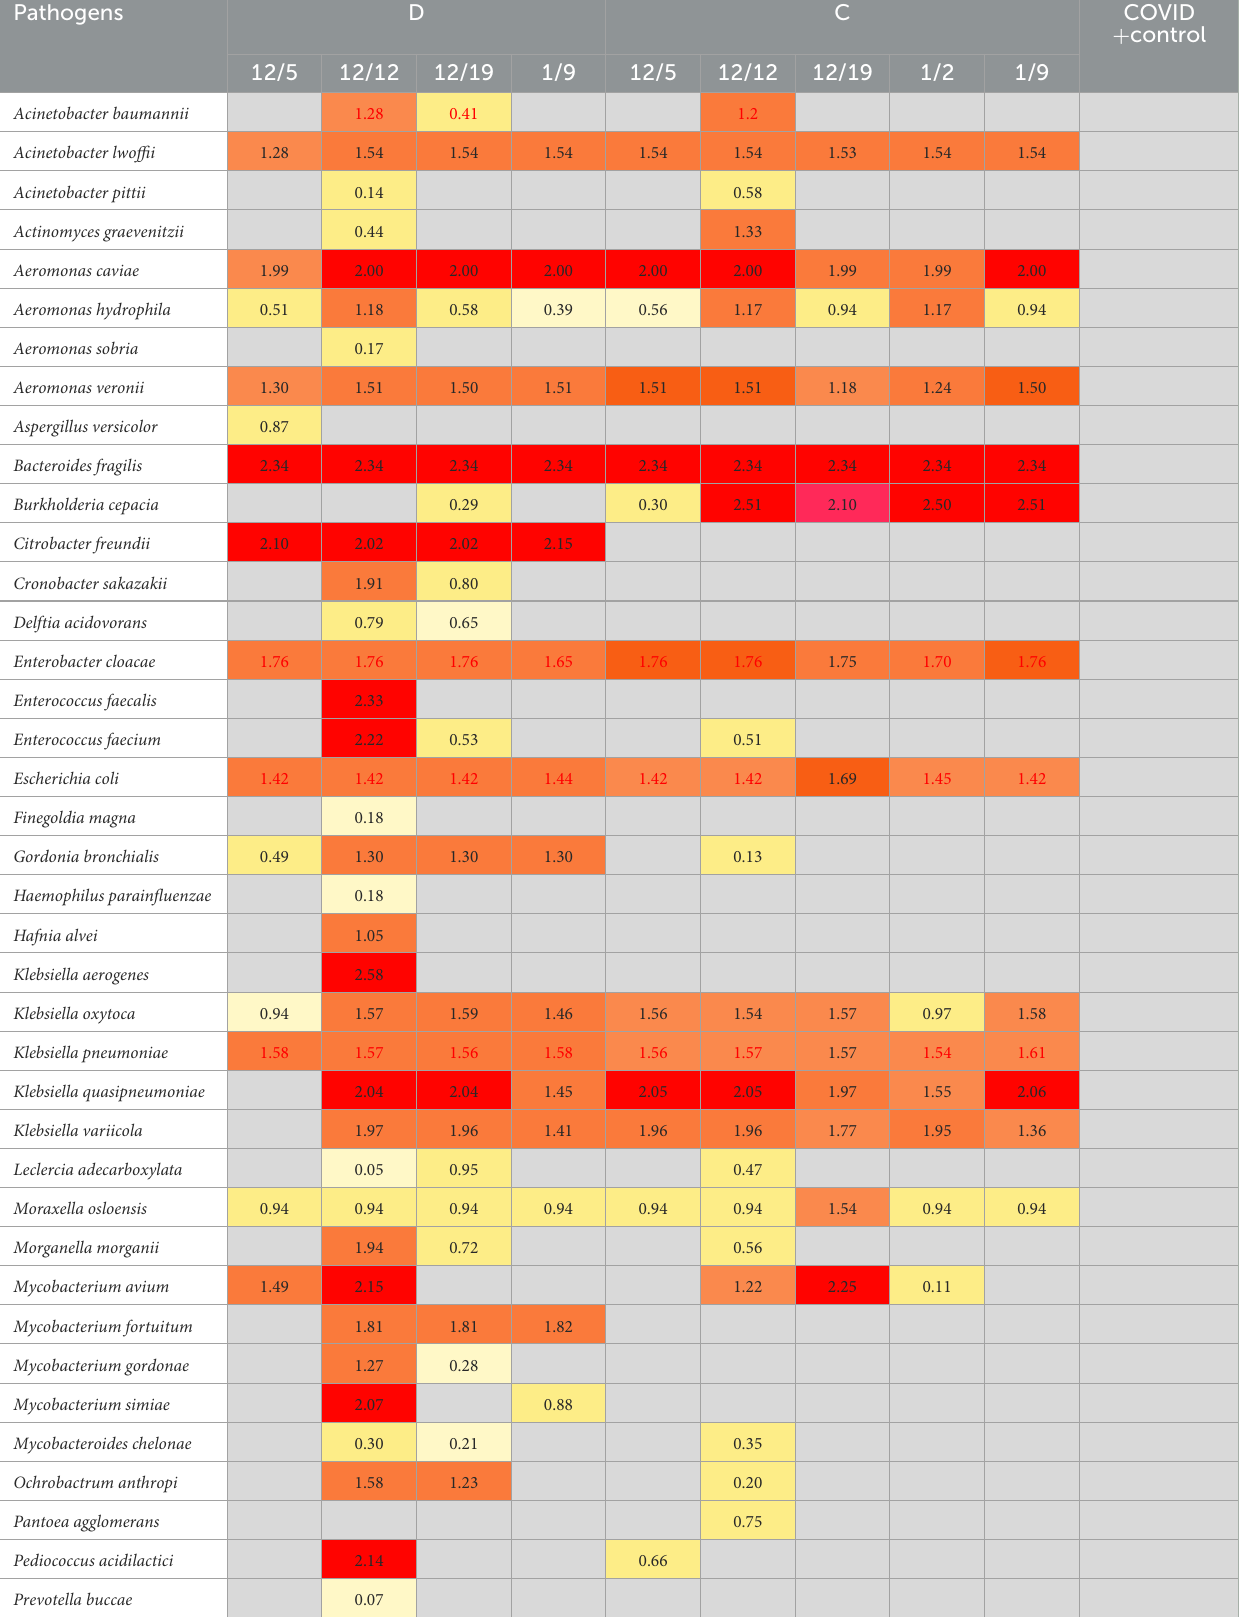
TABLE 6 Pathogens detected by the illumina respiratory pathogen and AMR panel in sites D and C over time. Pathogens D